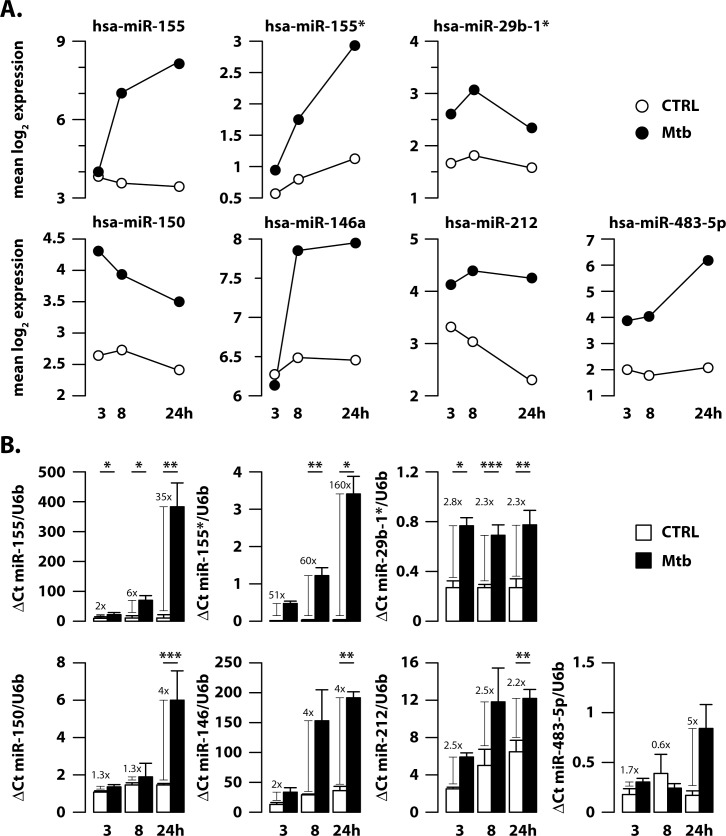
Validation of miRNAs altered in human DC during Mtb infection.DC were infected with Mtb for 3, 8 and 24 hours. (A) Time-series plots from array data of miR-155, miR-155*, miR-29b-1*, miR-150, miR-146a, miR-212 and miR-483-5p are shown. The selected miRNAs are all significantly up-regulated (FDR <0.05) during Mtb infection of human DC. When different probes corresponding to the same miRNA were found significant, the mean log2 expression profile across probes was plotted for the two conditions (CTRL and Mtb). (B) Relative expression of miR-155, miR-155*, miR-29b-1*, miR-150, miR-146a, miR-212 and miR-483-5p in human DC left untreated (CTRL) or infected for 3, 8 and 24 hours with wild type Mtb, as measured by q-PCR analysis. Data are derived from 3 healthy donors independently enrolled from those used for microarray and are normalized to the U6b level using the equation 2-ΔCt. The results shown were mean fold change per sample ± standard error of the mean at 3, 8 and 24 hours post-infection (*p = 0.005; **p = 0.02; ***p = 0.04).